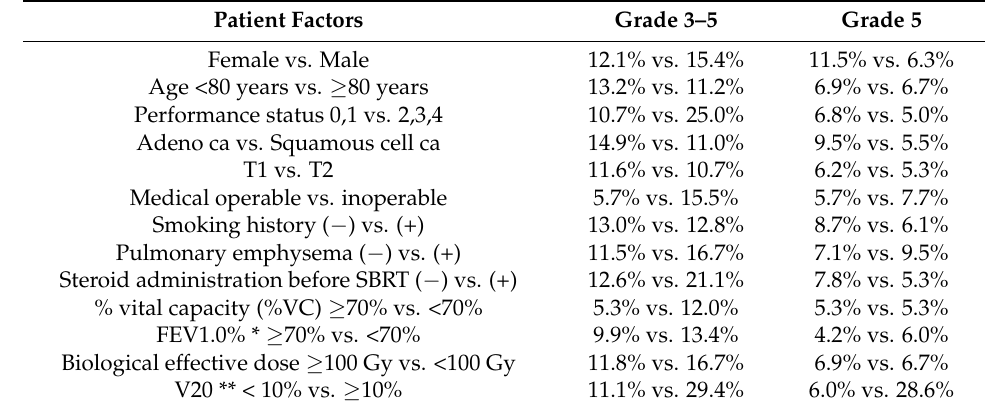
Table 3. Incidence of severe radiation pneumonitis according to patient